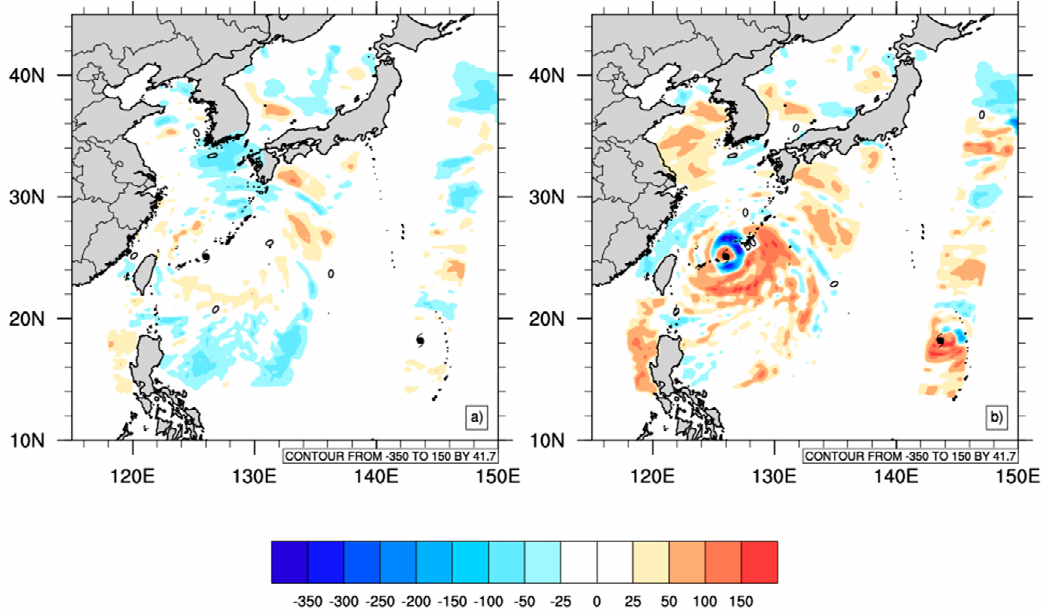
Figure 13. 500 hPa geopotential height difference (gpm) at 1800 UTC on 9 July from ( a ) CLEARSKY, ( b ) ALLSKY experiments, with black typhoon mark for Chan-hom and Nangka.